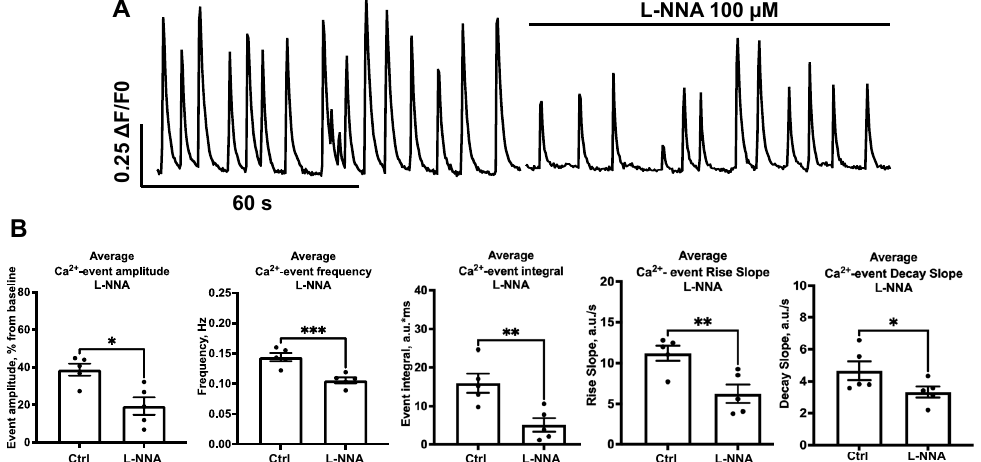
Figure 4. Influence of the L-NNA blocker on SCEs. ( A ) Typical recording of the influence of L-NNA on SCEs. ( B ) Normalized amplitude ( p * = 0.026), frequency ( p *** = 0.0001), integral ( p ** = 0.0091), rise slope ( p ** = 0.0088) and decay slope ( p * = 0.033) for these influences are shown.